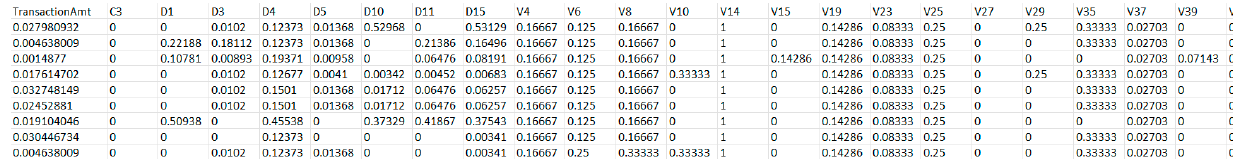
Figure 5. Sample of the used dataset before prepossessing phase. Table 1. The number of observations for each class (fraud and non-fraud) before and after SMOTE- ENN.